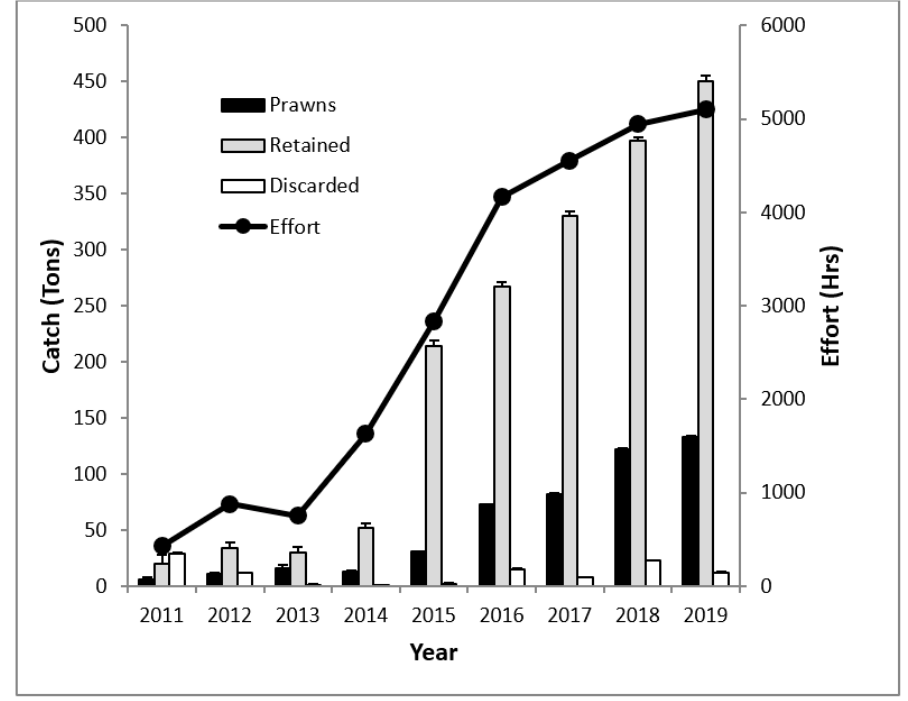
Figure 2. Annual trends in trawl catch and effort (±SE) in Malindi–Ungwana Bay in the 2011–2019 period.